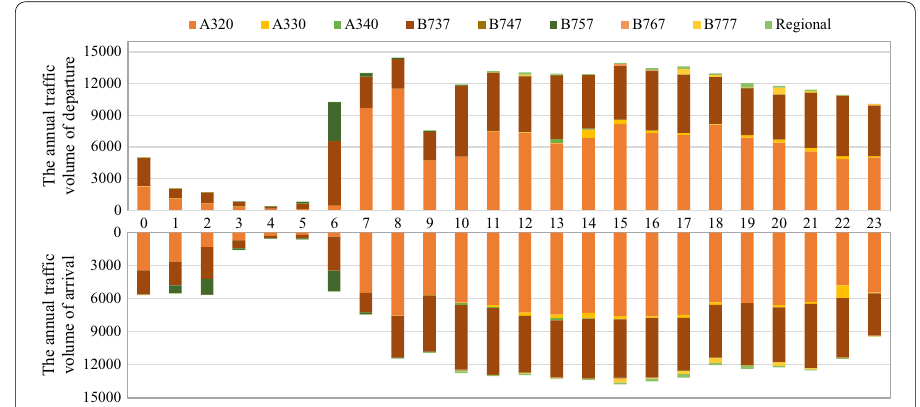
Fig. 3 Distribution of air traffic flow and aircraft type